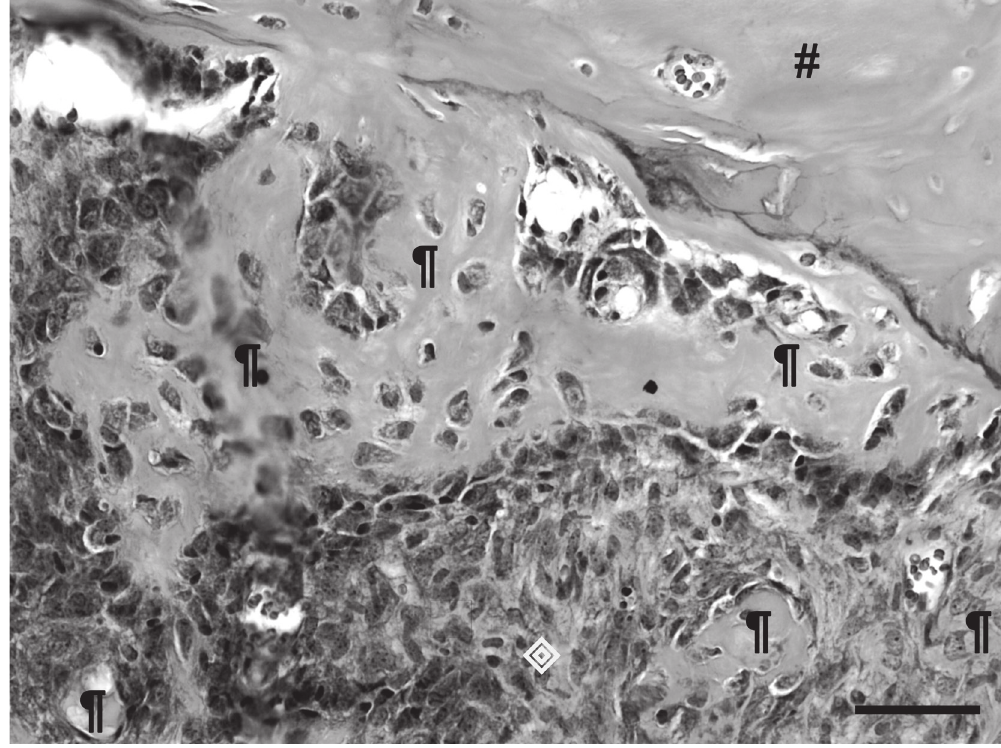
Figure 4 - Photomicrograph evidencing the microscopic aspect of the process of bone defect repair at 10 days in one animal from group MSC. Undifferentiated cellular types in the interior of the defect (  ), new bone formation disposed in islands (¶), and receptor bone (#). (HE) [escale = 100µm].